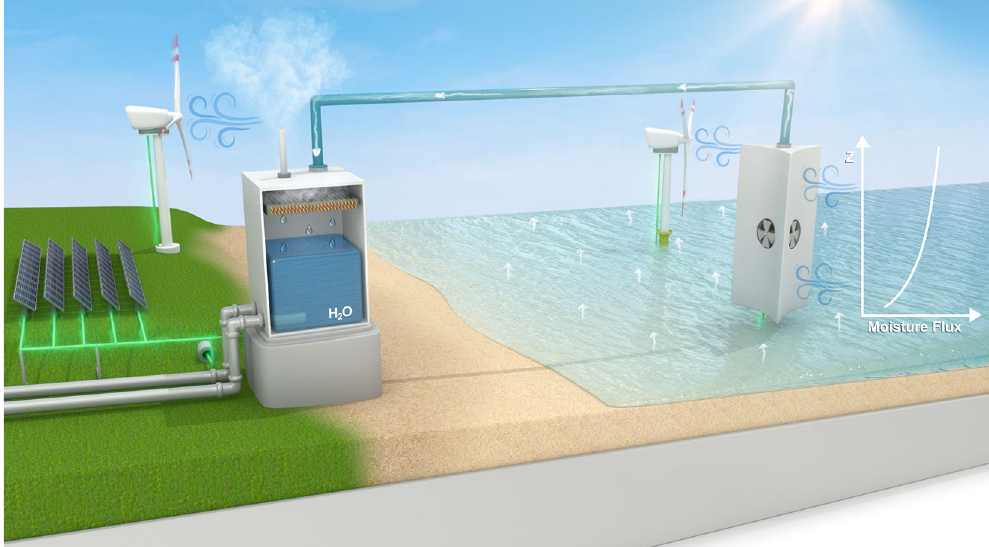
Figure 1. Schematic illustration of our proposed approach for capturing moisture above the ocean surface and transporting it to proximal land for improving water security. Evaporated moisture flux in the form of water vapor in the atmosphere above the ocean can be captured through an appropriately designed intake as conceptualized on the right, transported in the vapor phase through a conduit, and condensed over land as illustrated on the left to obtain fresh water. The moisture flux increases gently with altitude due to higher horizontal wind, offering the opportunity to design vertical capture surfaces. The intake can be designed to optimize the moisture intake taking into consideration the prevailing wind direction and its variation with altitude and time. A compressor can increase the efficiency of collecting the humid airmass at the intake. As illustrated in the Figure, renewable energy (wind or solar) can power the intake, transport, and condensation of moist air. We expect the intake to be located several kilometers offshore to ensure sufficient open water fetch isotropically around the intake. [Figure created using Adobe Photoshop, not to